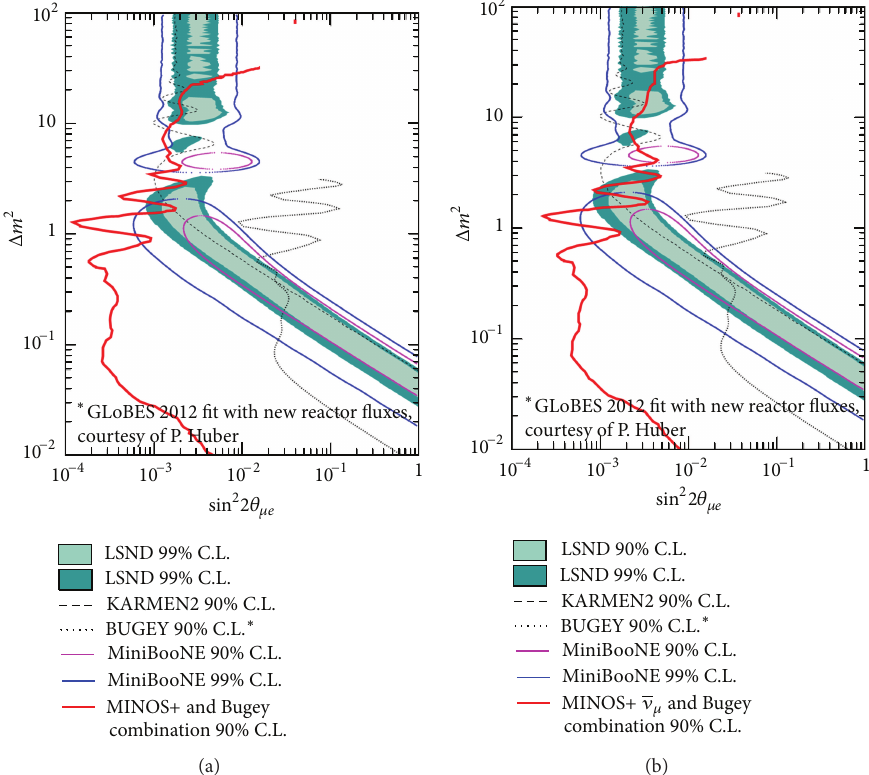
Figure 36: Expected sensitivities for MINOS+ combined with Bugey data to sin 2 (2𝜃 𝜇𝑒 ) as relevant for sterile neutrino searches. 90% C.L. contours are shown for exposures of 1.2 × 10 21 POT in both neutrino-enhanced (a) and antineutrino-enhanced (b) NuMI beam